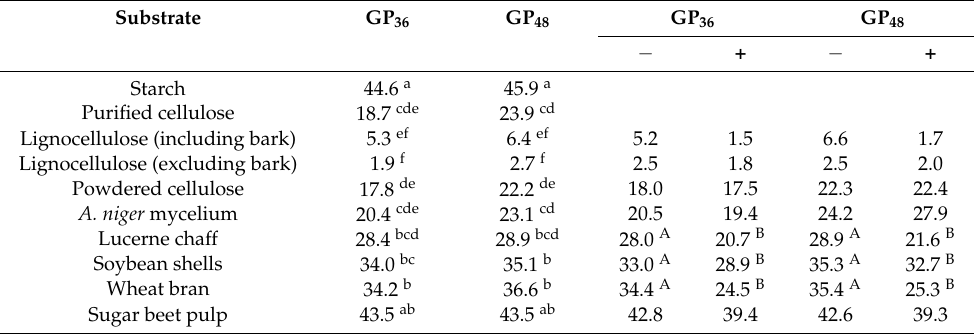
(Figure 1) and the resulting model estimates (Table 4). Incubation of lignocelluloses resulted in marginal gas production with a widely not convergent shape. Therefore, curve fitting was not applied in lignocelluloses. In the pre-digested materials, a biphasic shape of gas production was visible with a first peak around 2 h and a second gradual increase starting at 6 h after incubation (Figure 2). Table 3. Least squares means of gas production (mL/400 mg dry matter) after 36 (GP 36 ) and 48 h of incubation (GP 48 ) and the effect of enzymatic pre-digestion of the substrates. Substrate